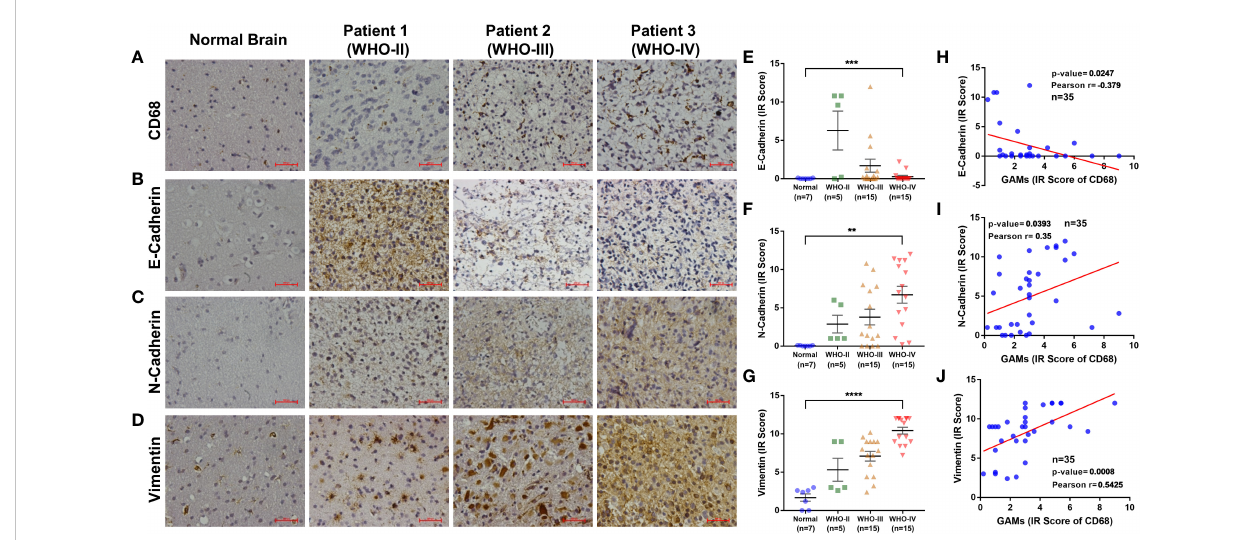
FIGURE 3 Analysis of the relationship between the degree of EMT and in fi ltration of GAMs in glioma samples. (A-G) Detection of the content of GAMs and the degree of EMT in normal brain and different grade glioma tissues by IHC. Representative IHC of GAMs (CD68 + ) in normal brain and different grade glioma tissues (A) . Representative IHC and statistical graphs of expression of EMT markers, E-cadherin (B, E) , N-cadherin (C, F) , and Vimentin (D, G) in normal brain and different grade glioma tissues. (H-J) The relationships between GAMs and EMT markers ’ expression in glioma tissues, including E- cadherin (H) , N-cadherin (I) , and Vimentin (J) . (Scale bars represent 200 m m; ** for p-value<0.01, *** for p-value< 0.001, and **** for p-value<